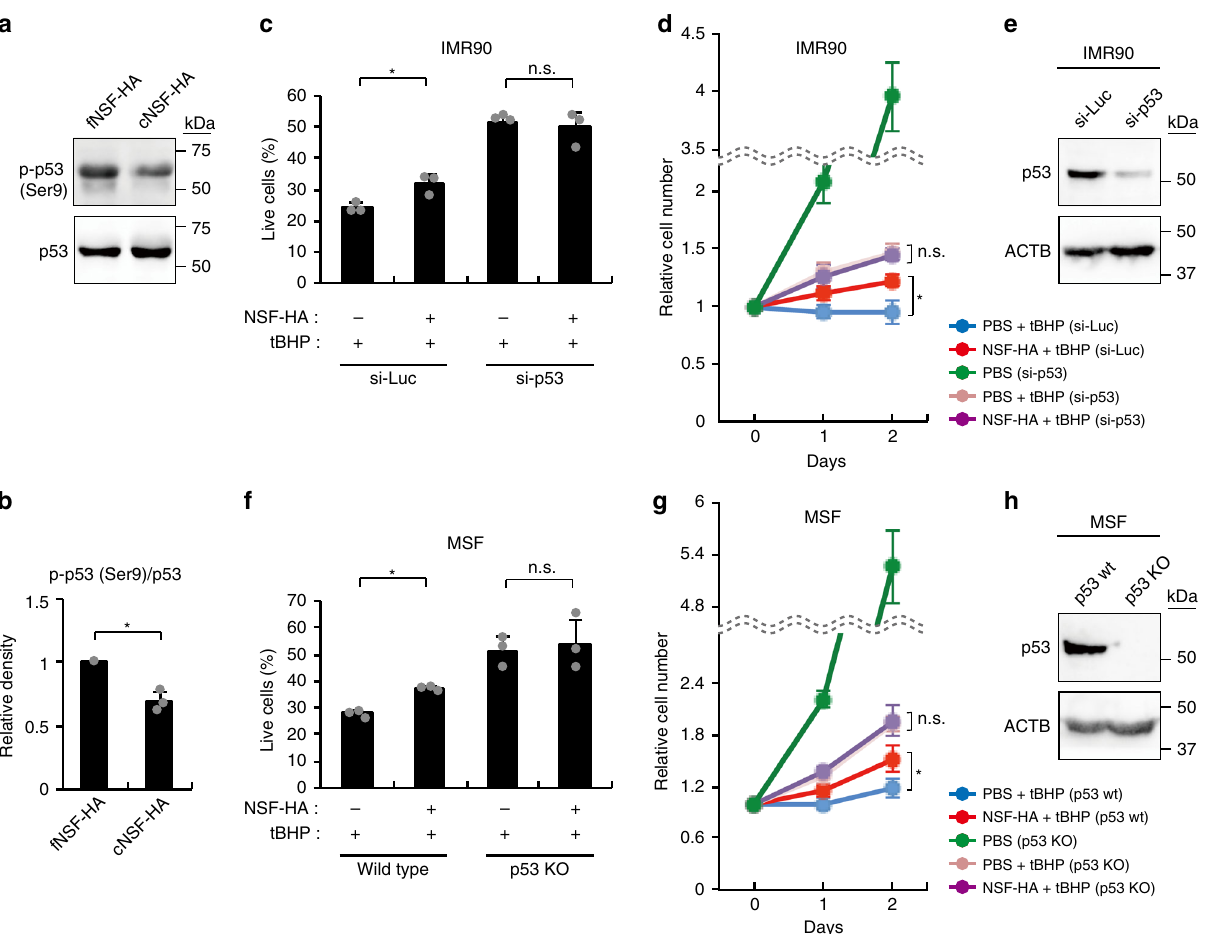
Fig. 4 Cytoprotective effect of NSF-HA depends on p53. a Western blots showing p-p53-Ser9 levels in IMR90 cells treated with 20 μ g/ml cNSF-HA or fNSF-HA for 6 h. b Quanti fi cation of Western blots shown in ( a ) by Image J. Averages are of three biological replicates. For each biological replicate, immunoblotting was performed three times and averaged. c p53-knockdown abrogates the cytoprotective effect of NSF-HA on oxidative stress-induced cell death in IMR90 cells. The percentages of live cells were measured by Annexin-V/PI staining 1 day after 1 h of 3 mM tBHP-treatment ( n = 3). Cells